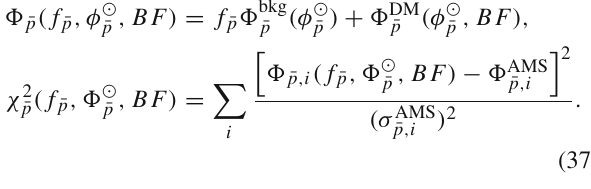
Fig. 5 The Sommerfeld enhancement factor S E in our model as a function of mediator mass M Z (cid:3) (left) and M H parameters in Tables 3 and 4